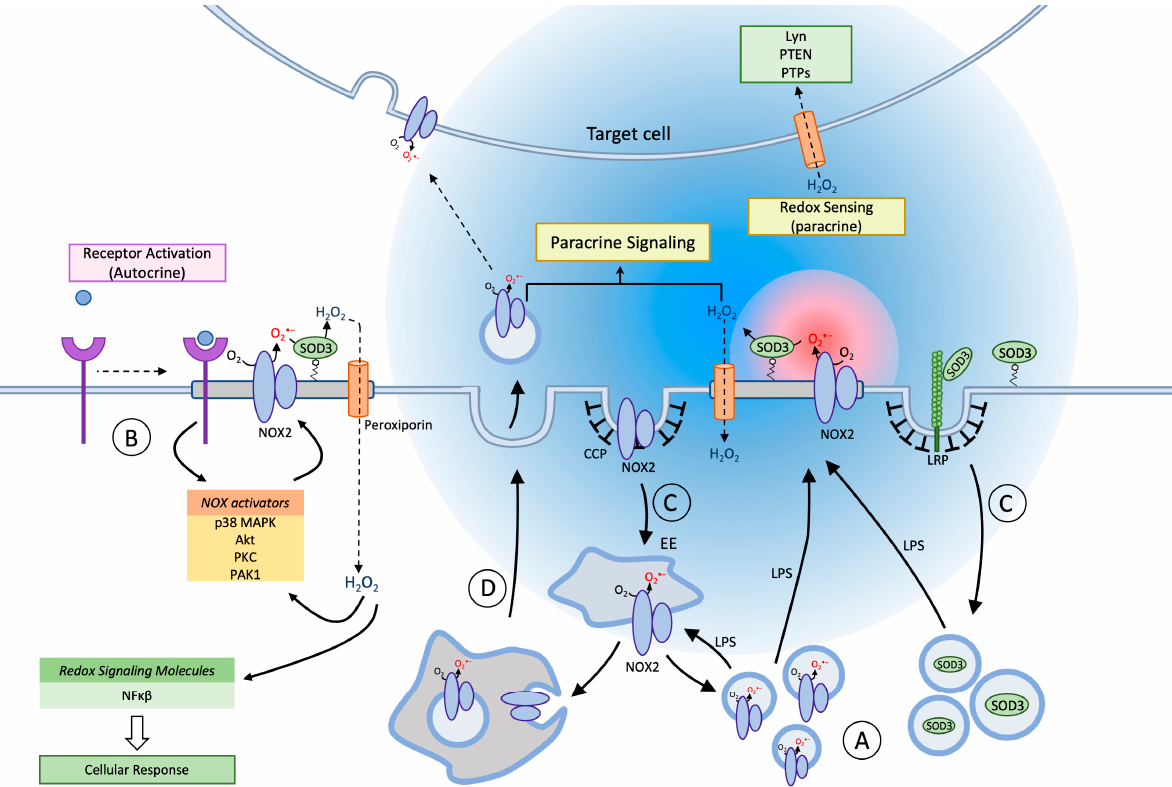
Figure 2. Membrane trafficking and Redox signaling of NOX2 and SOD3. In blood-derived macrophages and tissue macrophages, NOX2 and SOD3 are contained in separate agonist-responsive secretory vesicle populations distinct from, but communicating with, the endosomal compartment ( A ). Inflammatory activation (e.g., LPS) of macrophages causes mobilization and exocytosis of the vesicles to enrich the cell surface in superoxide production capacity (red sphere). On the cell surface NOX2 is organized in lipid rafts, and the agonist-induced planar inclusion of also SOD3 into this ensemble drives a rapid dismutation of superoxide to establish a steep gradient of hydrogen peroxide (blue sphere) for autocrine and paracrine signaling. Peroxiporin channels are likely also included in lipid rafts, which facilitates redox signaling by allowing hydrogen peroxide easier access to redox targets in the cytosol of the producing cell (autocrine) or in nearby cells (paracrine mode). Certain cell surface receptors signal directly or indirectly through redox circuits ( B ). Proximal signaling from the receptor causes activation of various NOX2 activators, and in the presence of SOD3 the ensuing hydrogen peroxide production amplifies, sustains and diversifies receptor signaling. NOX2-derived oxidants may also directly target a growing number of intracellular redox sensors e.g., nuclear factor kappa-light-chain-enhancer of activated B cells (Nf-kB) to induce altered signaling and transcription. Both NOX2 and SOD3 are internalized from the cell surface through clathrin-coated pits, and reach their respective storage compartments by unknown endosomal sorting mechanisms ( C ). A minor fraction of NOX2 will continuously be present in endosomal compartments and on the cell surface, but immune cell activation increases cell surface exposition of NOX2 and SOD3 several-fold by mobilization of secretory vesicles. The fraction of NOX2 in the endosomal pool is functionally important because NOX2, in an assembled and active format, can be sorted into intraluminal vesicles of multivesicular bodies/late endosomes, which are then discharged into the surroundings by exocytosis as exosomes ( D ). Exosomes can now confer novel oxidant production capacity to neighboring target cells, after fusion with their plasma or endosomal membranes to insert the NOX2 complex. [30], and the acquisition of specific macrophage activation states or metabolic profiles is to a large extent also under redox control [7,75]. Macrophages may polarize to either an M1 phenotype (proinflammatory, pathogen elimination, oxidant production including